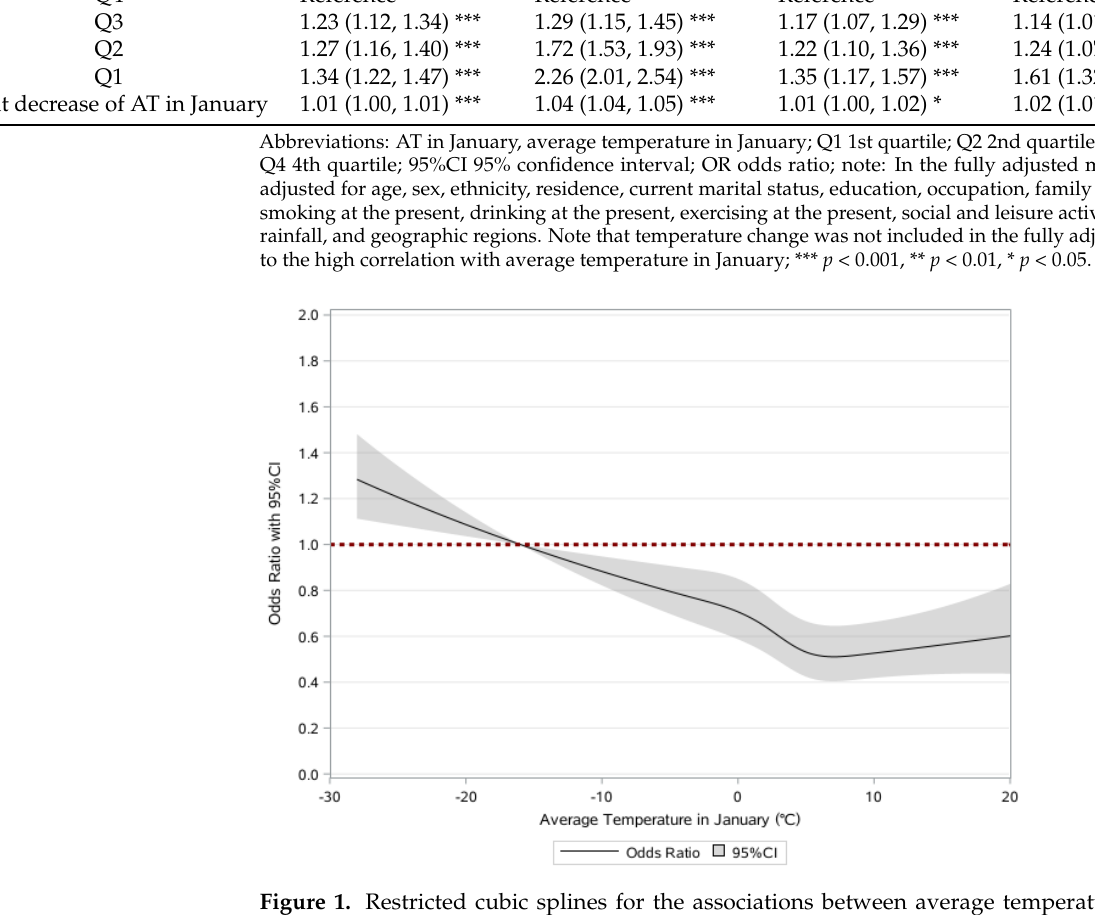
Figure 2. Subgroup analysis for the associations between each 1 °C decrease of average temperature in January and frailty.